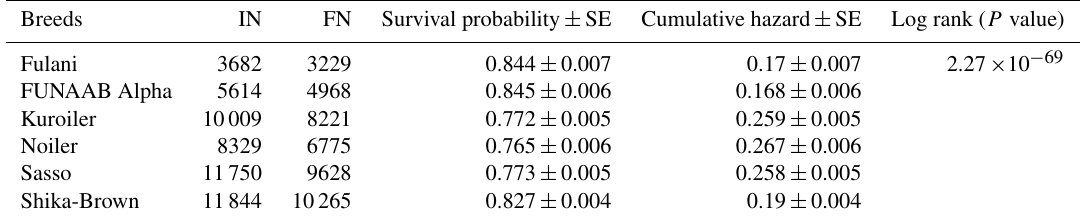
Figure 3. Actual mortality of female birds during laying phase in ACGG project zones (20–72 weeks) (2016–2018). Table 8. Effect of breed on overall on-farm survival performance of birds (male and female) during growing phase in ACGG Nigeria project zones (6–18 weeks) (2016–2017).